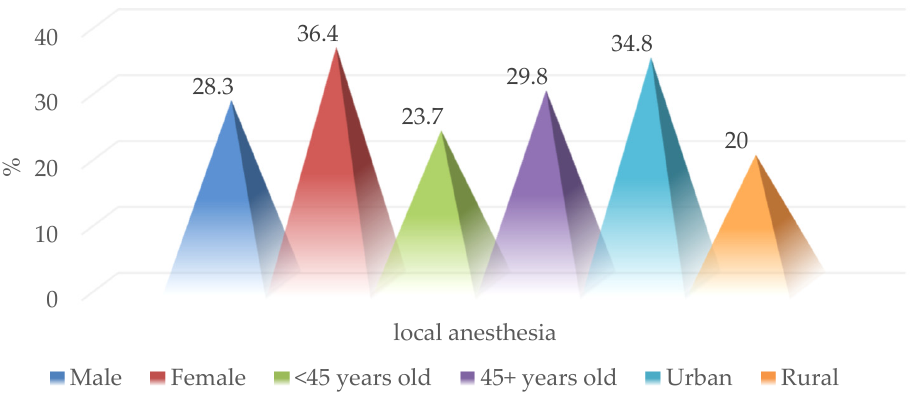
Figure 7. Distribution of cases surgically explored under general anesthesia according to the injury mechanism.